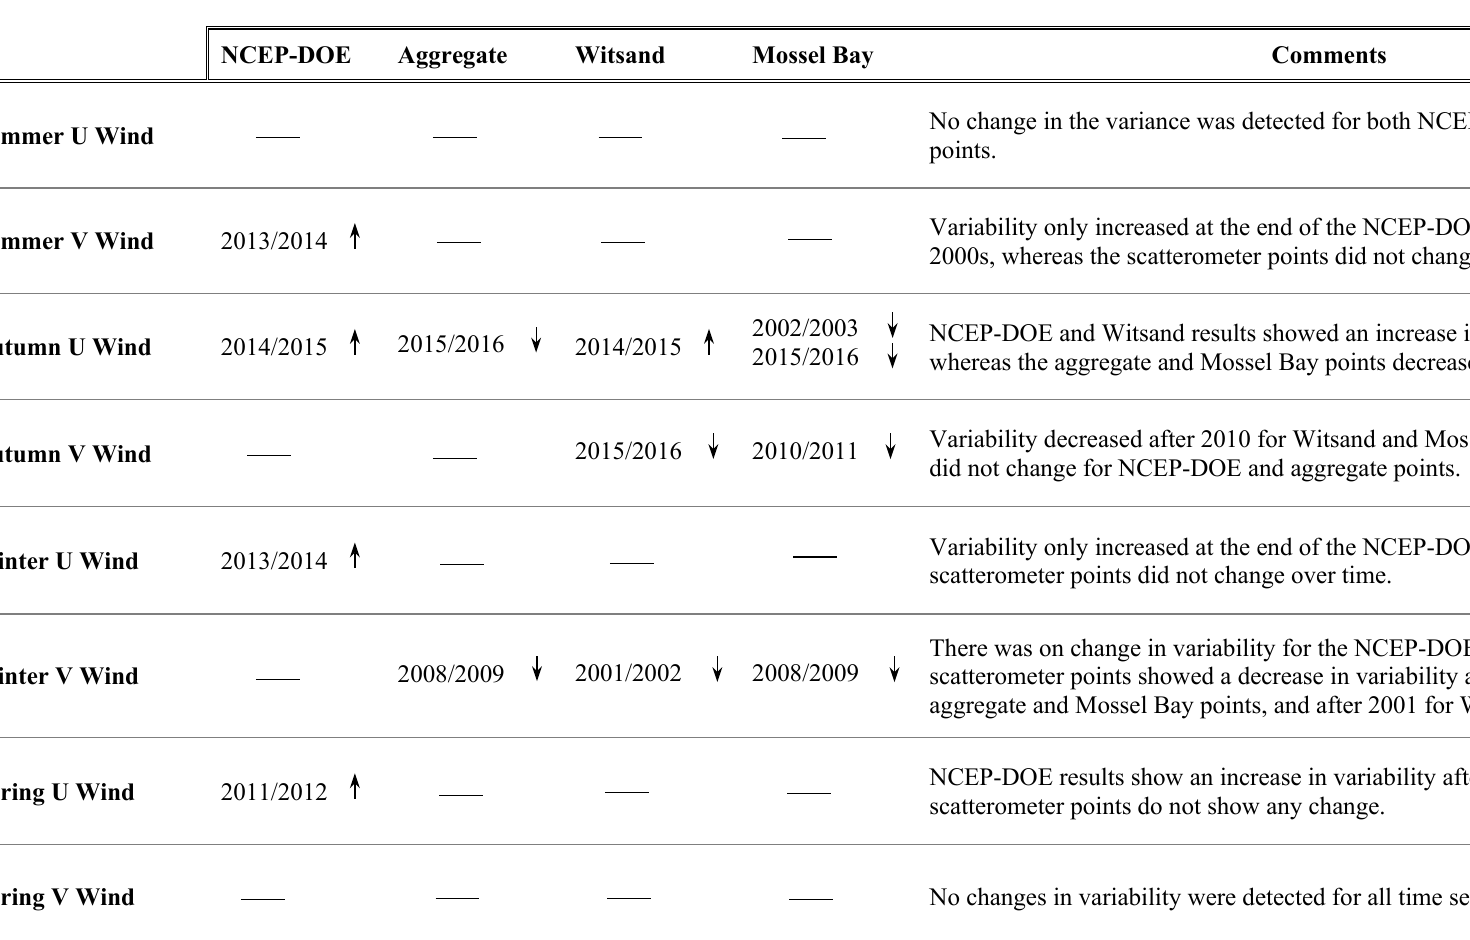
Table A 5 .4: Wind regime patterns for specific seasons between near- and off-shore time series analysing